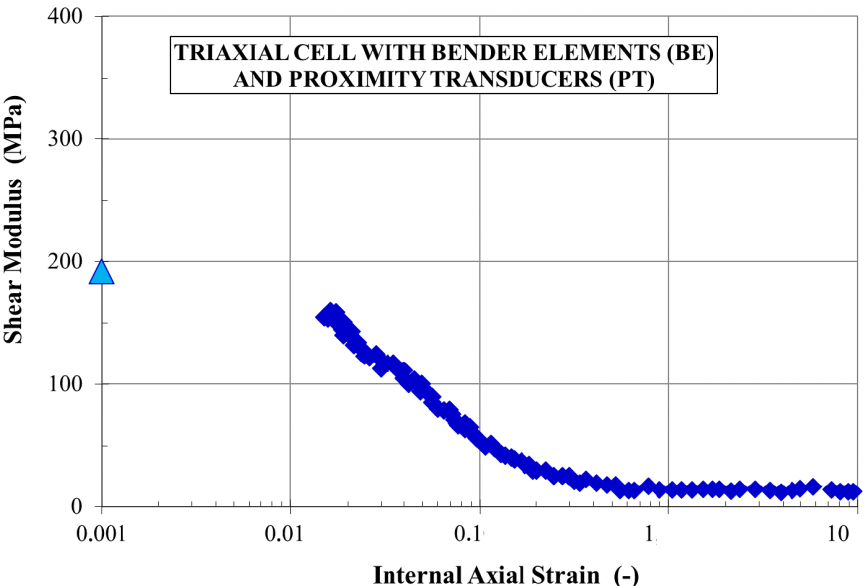
Figure 10. Maximum values of shear modulus G obtained from tests with wave velocity measure- ment and the rest obtained from tests in a precise triaxial apparatus with an internal measurement system [62].